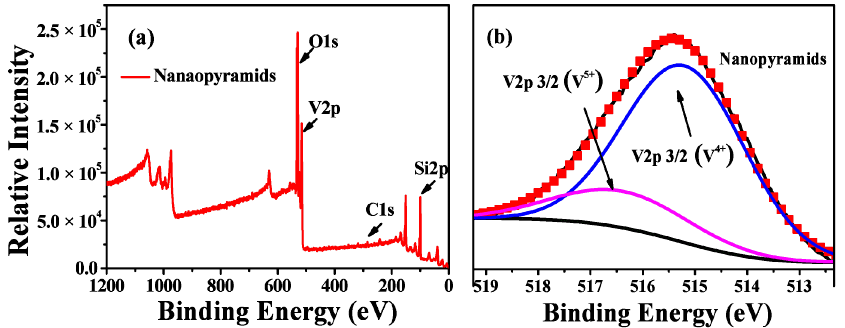
Figure 3. Wide-range survey XPS spectra ( a ) and high-resolution XPS profiles ( b ) of V 2 p for VO 2 nanopyramidal films obtained by oxygen etching at 540° for 1 h.